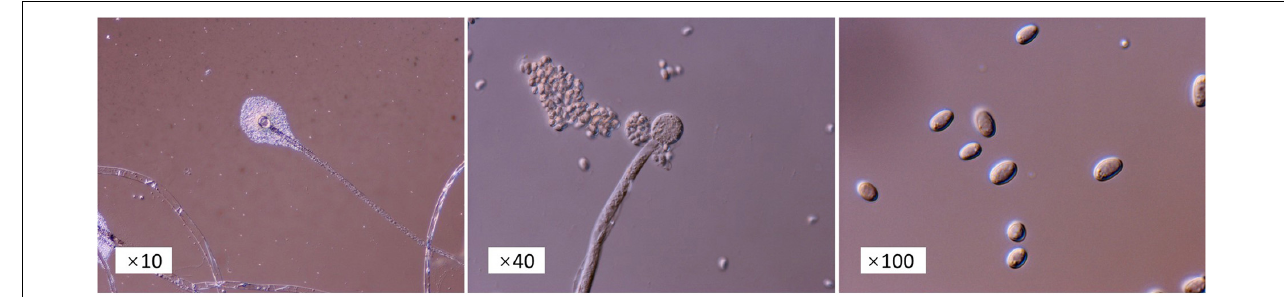
FIGURE 2 | Microscopic morpha of NMCel-crop1 magnified at 10, 40, and 100 times.